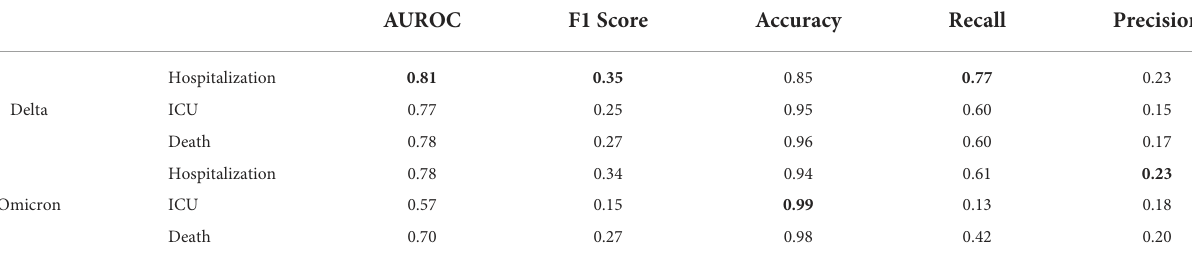
TABLE 3 Performance metrics for XGBoost analysis of Delta and Omicron COVID-19 analyses of hospitalization, ICU admittance, and death. AUROC F1 Score Accuracy Recall